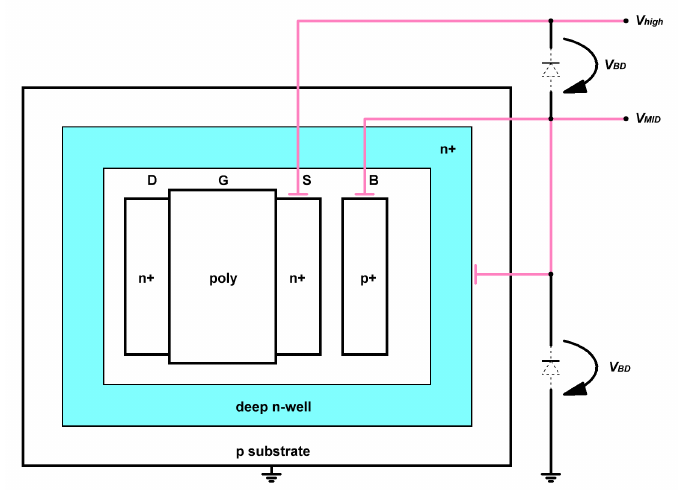
Figure 2. Diode structure built with deep n-well for the Dickson charge pump II